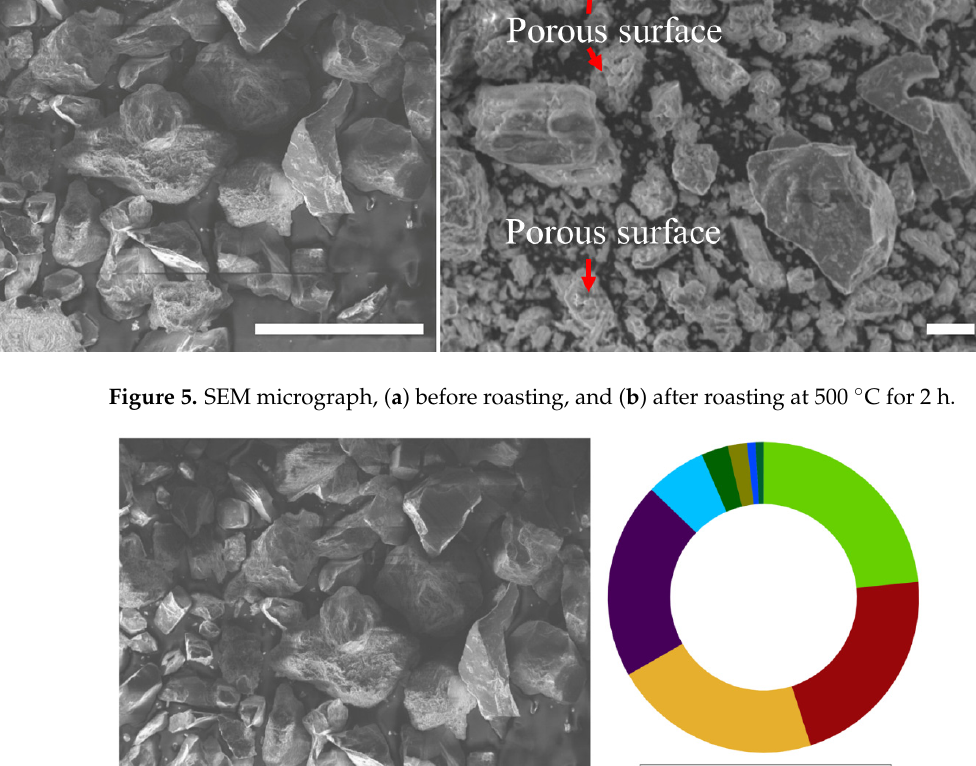
Figure 6. SEM-EDS of sulfide concentrated gold sample; the scale bar is 250 μ m.